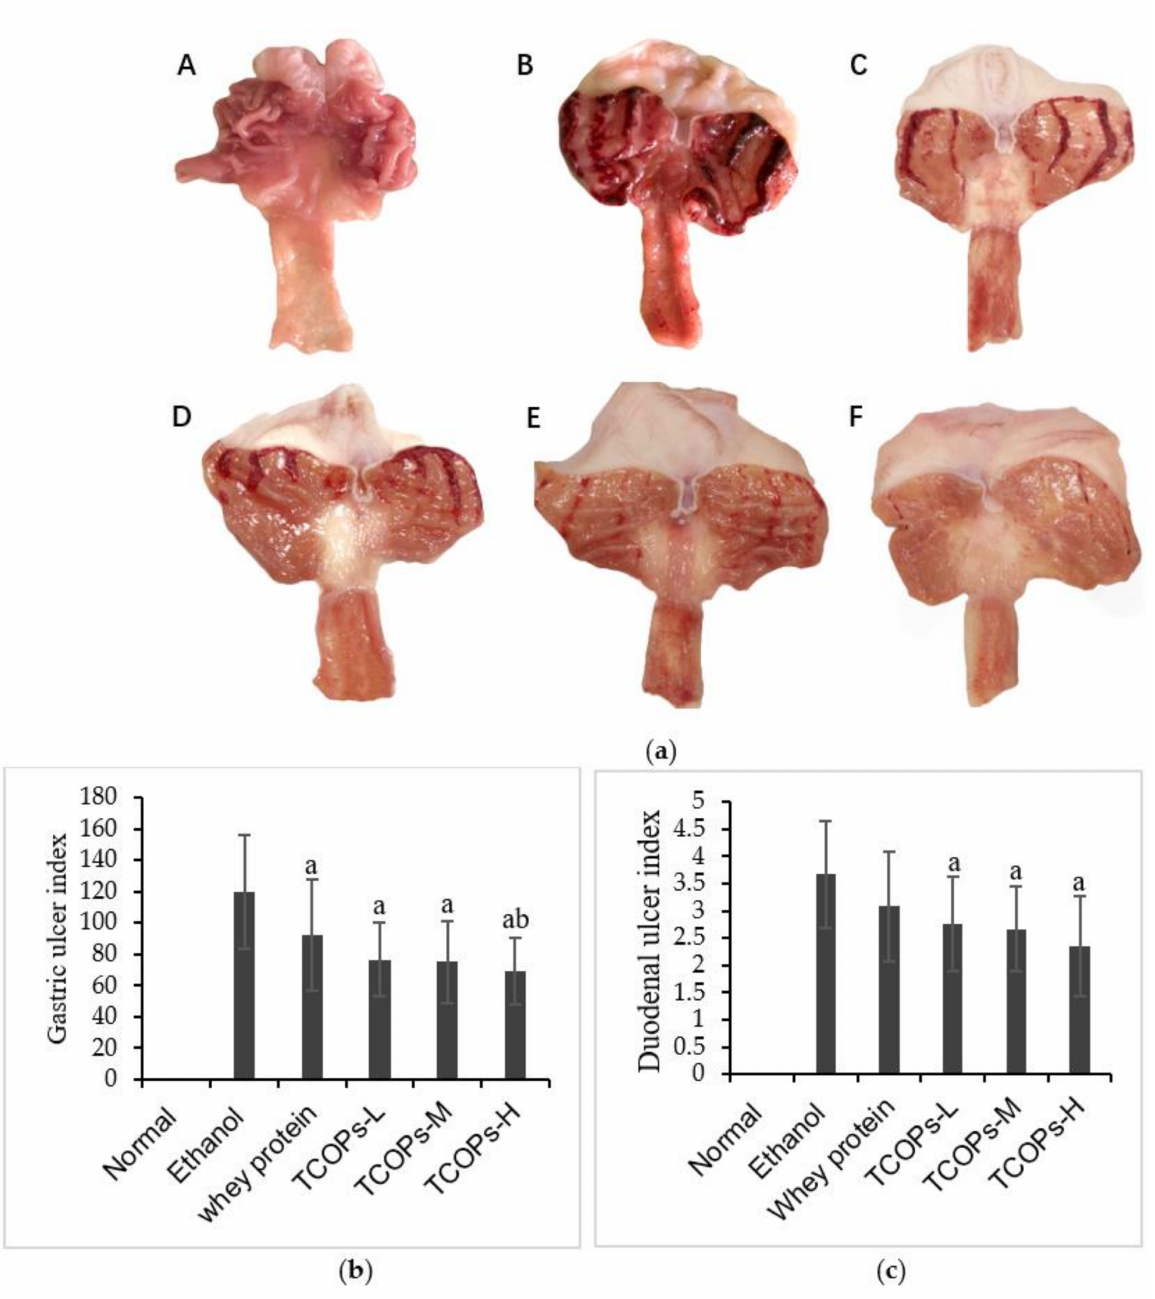
Figure 1. Effect of tilapia collagen oligopeptides (TCOPs) on gross evaluation ( a ) and ulcer index of gastric ( b ) and duodenal ( c ) mucosa in rats. Values are expressed as mean ± SD ( n = 12). a: means compared with the ethanol group, p < 0.05; b: means compared with the whey protein group, p < 0.05. A : normal control; B : ethanol; C : whey protein; D : TCOPs-L, 250 mg/kg of tilapia collagen oligopeptides group; E : TCOPs-M, 500 mg/kg of tilapia collagen oligopeptides group; F : TCOPs-H, 1000 mg/kg of tilapia collagen oligopeptides